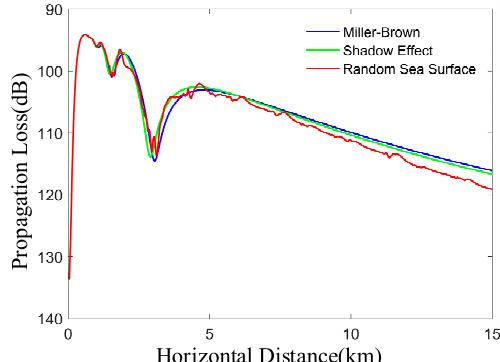
Figure 12. The effects of three models on propagation loss. The roughness attenuation factor of rough sea surface is divided into random sea surface model, Miller-Brown model and propagation loss considering shadow effect.